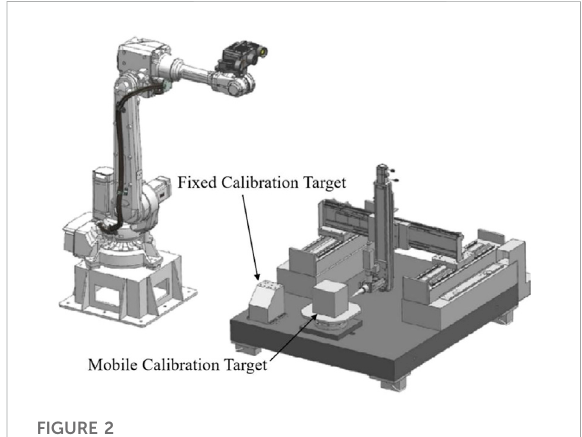
FIGURE 2 The fi xed calibration target and the mobile calibration